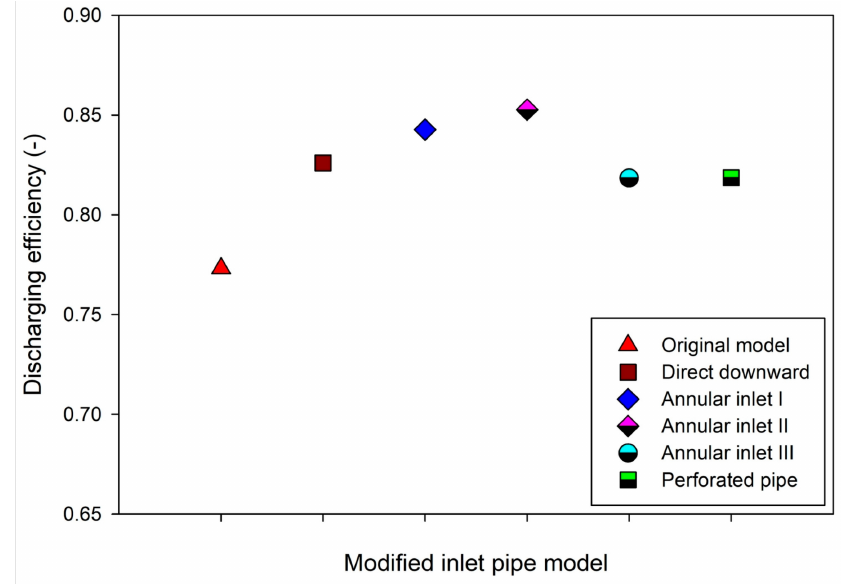
Figure 12. The discharging efficiencies of the modified inlet pipe models.